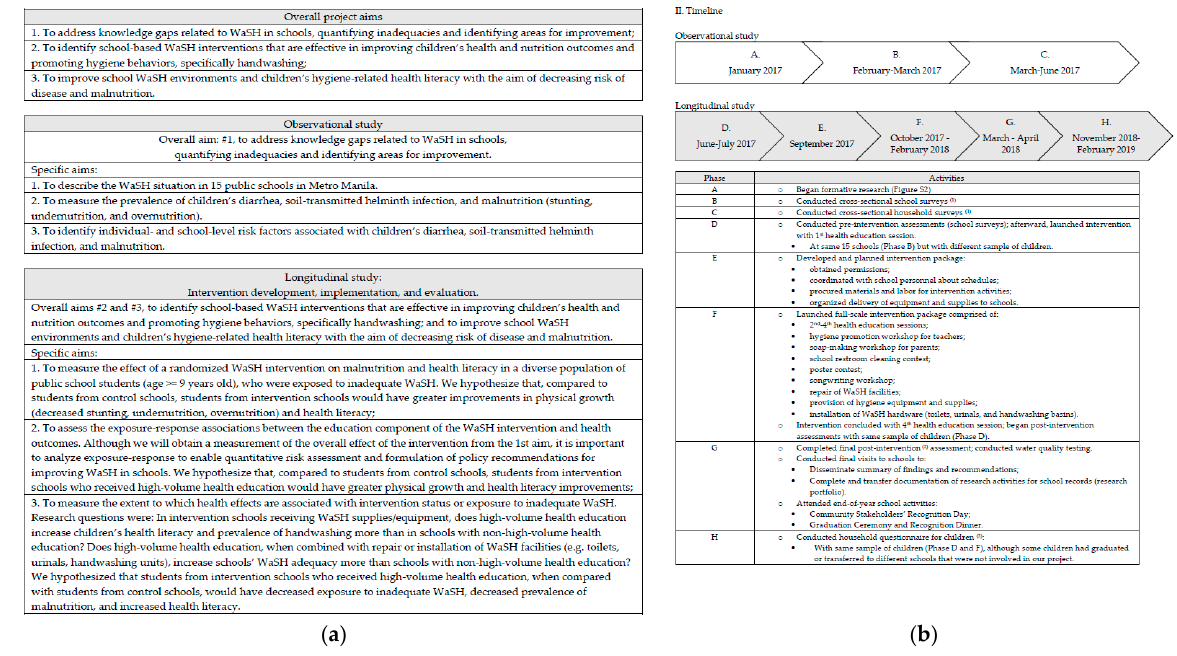
Figure 2. WaSH in Manila Schools project aims and timeline. Note: water, sanitation, and hygiene (WaSH). ( a ) Aims of overall project, observational study, and longitudinal study. ( b ) Timelines for observational study and longitudinal study, including research activities. (1) Please see References [27]. (2) Eight months after implementing the intervention, we revisited children from the control and intervention arms for a follow-up assessment that used the same study design as the baseline assessment. We used the same survey instruments to measure: children’s health literacy (Tables S3 and S4) and health and nutrition outcomes; children’s handwashing prevalence; school restrooms’ WaSH adequacy; and schools’ WaSH policies. (3) In November 2018, 17 months after implementing the intervention, we administered a household questionnaire for children (Table S5), some of whom had graduated and/or transferred to different schools. We completed the household questionnaire in February